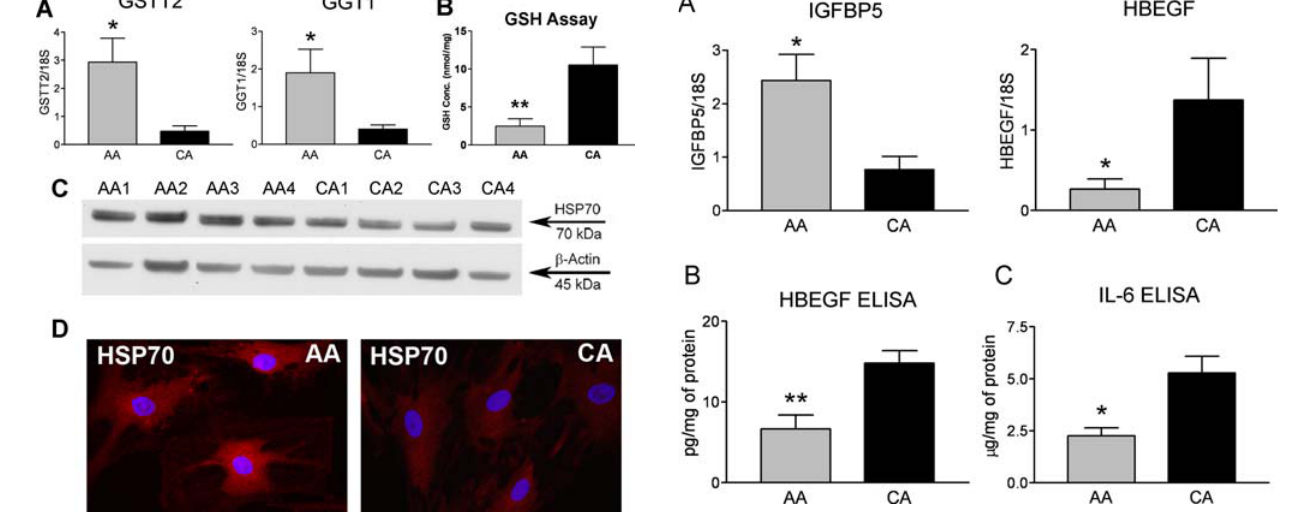
Figure 6. Upregulation of glutathione (GSH) metabolic en- zymes in AA astrocytes. A. Confirmation of two differentially expressed glutathione metabolic enzyme genes by qRT-PCR in human normal ONH astrocytes: glutathione S-transferase theta 2 (GSTT2) and gamma-glutamyltransferase 1 (GGT1). Genes were normalized to 18S. Graphical representation of the relative mRNA levels in AA and CA astrocytes (n=8, respectively, * indicate p , 0.05 in two-tailed t-test). B. AA astrocytes have significantly lower level of intracellular GSH in vitro, compared to CA astrocytes (n=10, ** indicated p , 0.01 in two-tailed t- test). GSH content is normalized by the amount of the protein. C. Representative Western blots of astrocyte cell lysates with heat shock 70 kDa protein (HSP70) antibody. b -actin was used as a loading control. HSP70 levels are higher in AA astrocytes compared to CA astrocytes. D. Immunofluorecent staining for HSP70 shows that AA astrocytes exhibit more abundant intracellular HSP70 staining compared to CA astrocytes. Magnification bar: 25 m m.